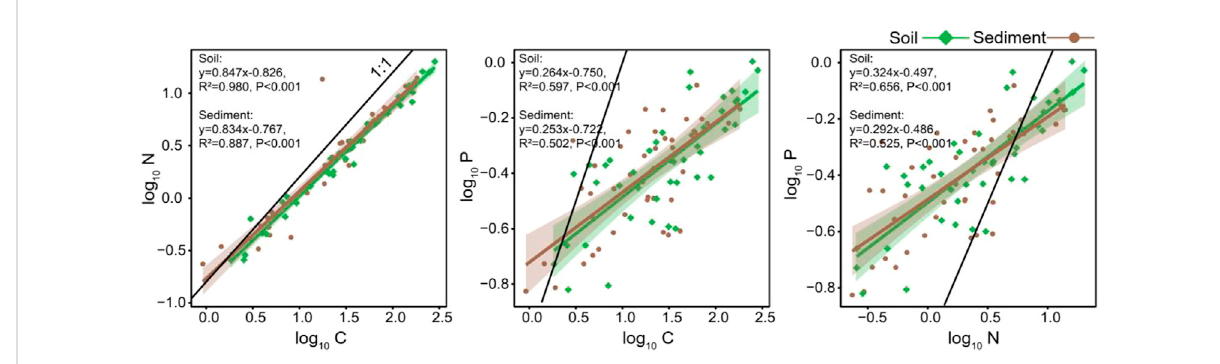
TABLE2Isometric/allometricrelationshipsamongC,N,andPconcentrationsinsoilandsedimentaccordingtothefunctionlog 10 (y)=a×log 10 (x)+b. Slope was tested comparing to 1. All the variables have the same unit,